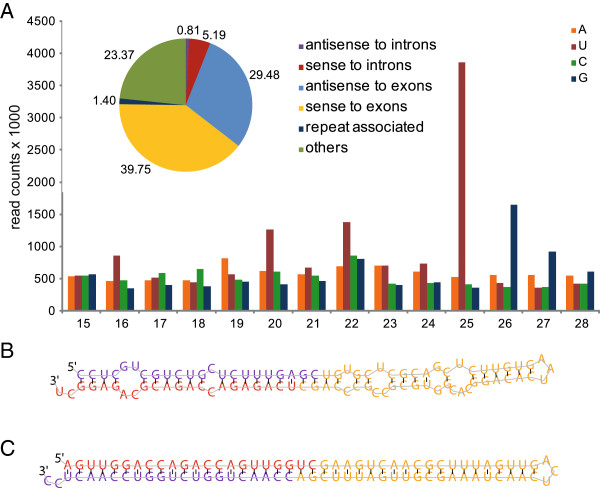
smRNA identification in Symbiodinium microadriaticum over 9 experimental treatments. (A) Lengths, read count distribution, and 5' identity of 5,125,940 distinct genome-matching small RNAs from the set of 137 million sequenced reads. All small RNA reads were mapped to a draft genome assembly via bowtie software. Genomic location is indicated in the pie chart. (B) miRDeep2 output for a miRNA precursor indicating the guide (red) and passenger (blue) strand as well as the hairpin loop (yellow). (C) miRDeep2 output for a siRNA precursor. Note the perfect complementarity between guide (red) and passenger (blue) strand as well as the hairpin loop (yellow).